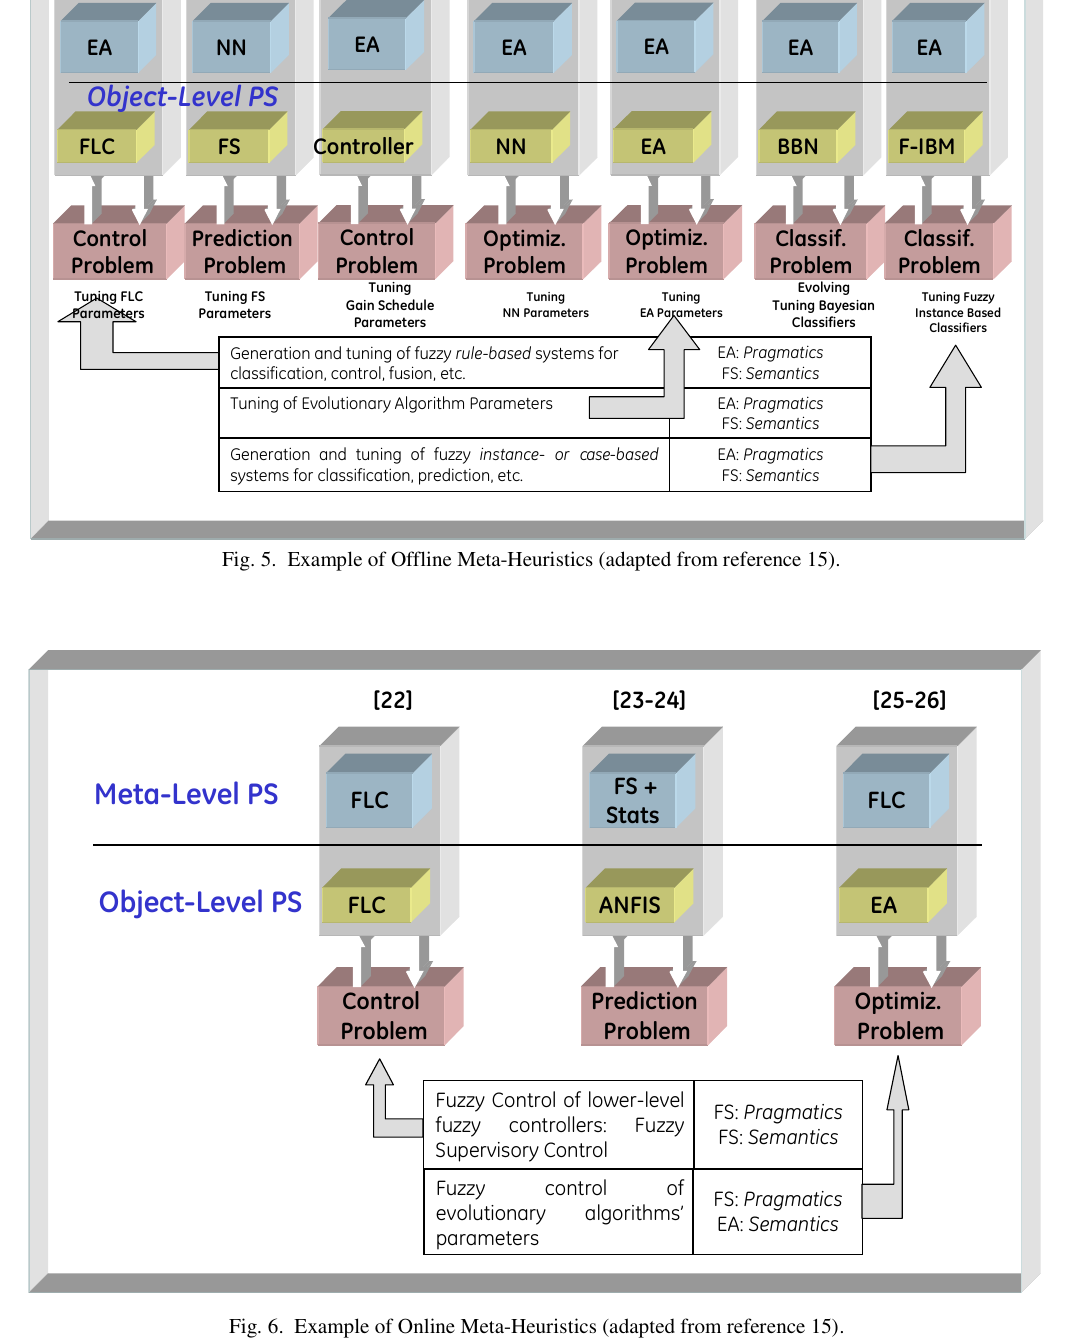
Fig. 6. Example of Online Meta-Heuristics (adapted from reference